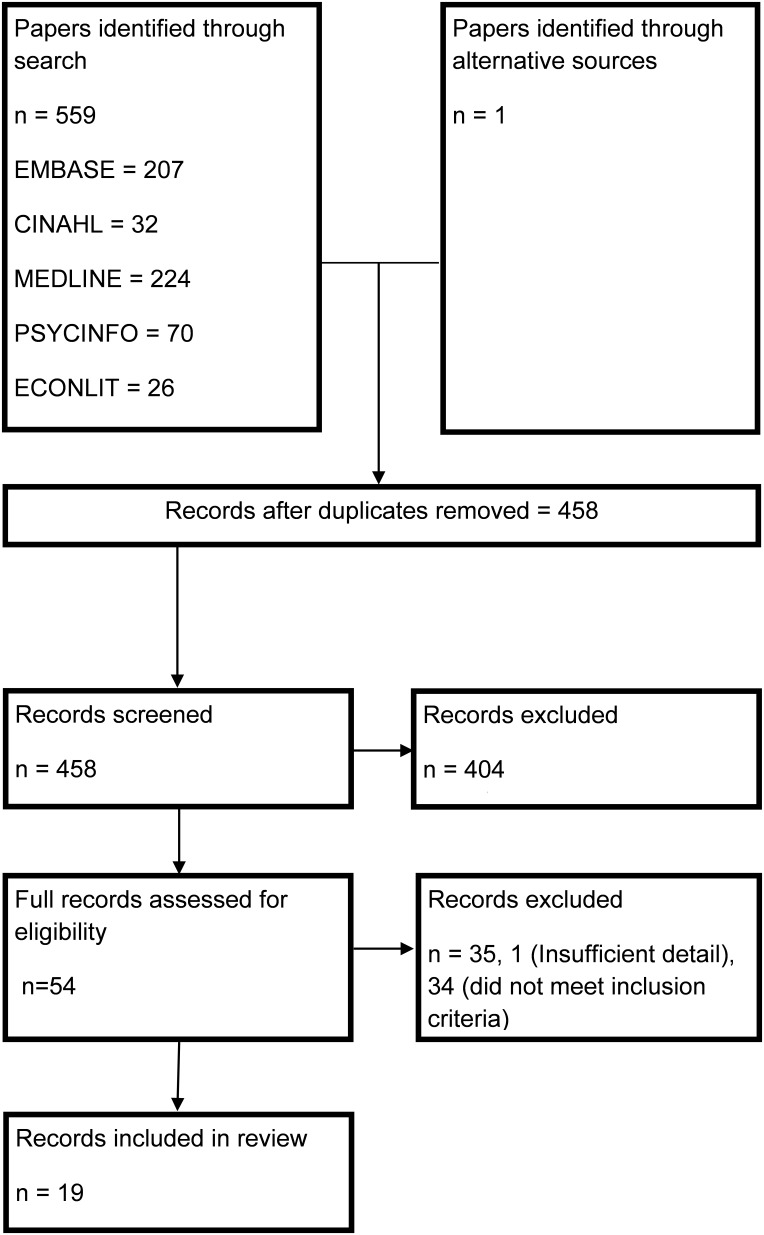
PRISMA Flowchart.